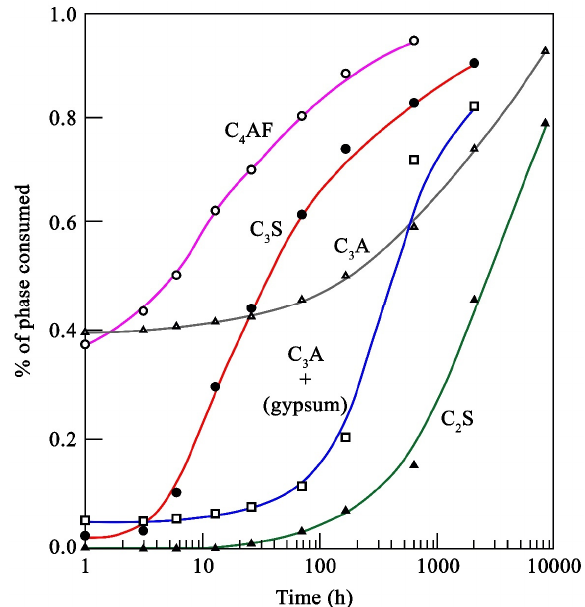
Figure 1. Typical hydration kinetics of the pure phases of cement clinker at room temperature (adapted from reference [19]).